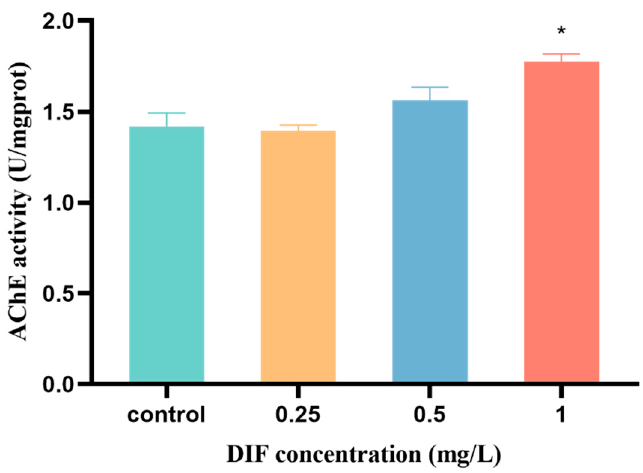
Figure 5. The AChE activity in zebrafish embryos measured following exposure to difenoconazole (0, 0.25, 0.5, and 1 mg/L). Values are expressed as mean ± SEM of 3 replicates (100 larvae/replicate). * p < 0.05 indicates significant differences between exposure groups and the control group.